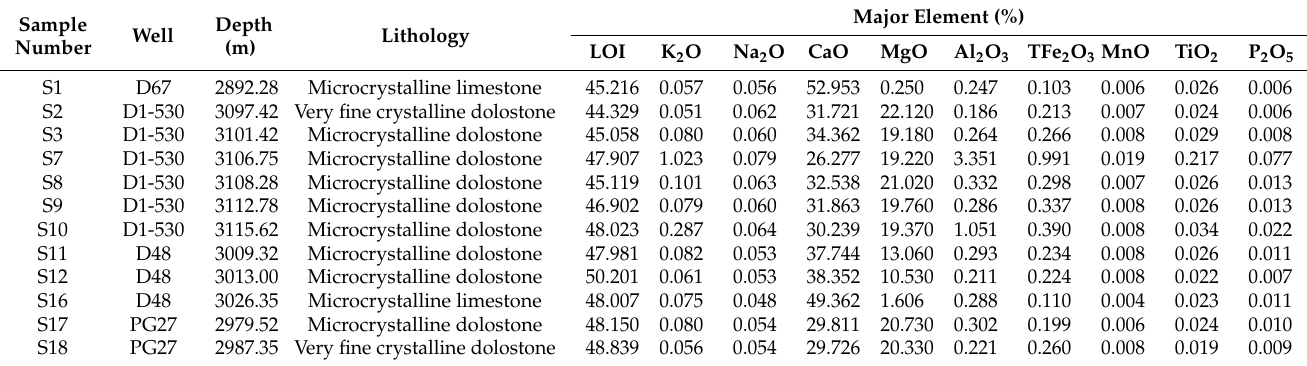
Table 4. Relative content of the major elements and loss on ignition results of the samples. Sample